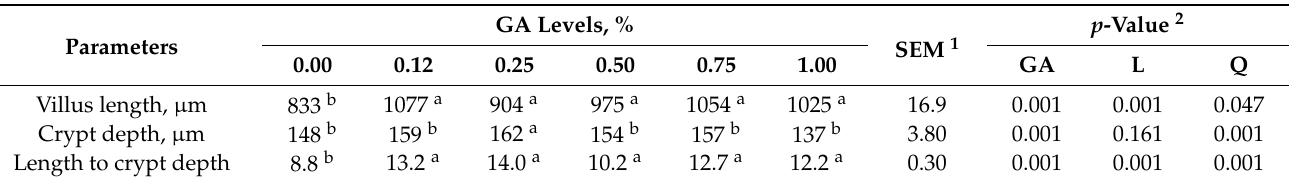
Table 9. Effect of gum Arabic (GA) on duodenal histomorphometric of male broiler chickens on d 10 of